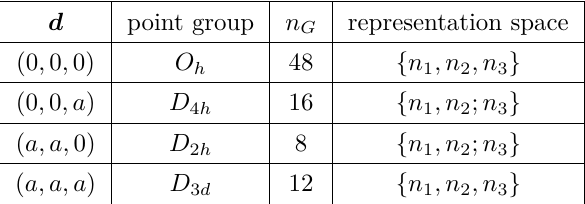
Table 1 . The point groups, their orders n G , and representation spaces of the two-particle systems in finite volume as defined in eqs. (3.3) and (3.4).